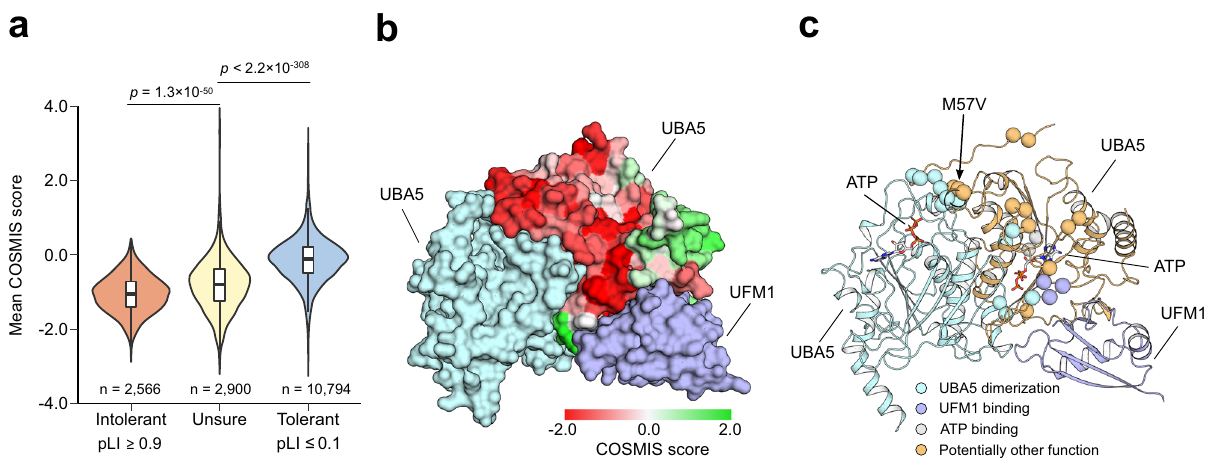
Fig. 4 The COSMIS score quanti fi es constraint at amino acid resolution and provides structural insights into variant pathogenicity. a COSMIS score distributions are signi fi cantly different between loss of function tolerant, unsure, and intolerant (as de fi ned by pLI) genes. The COSMIS scores of amino acid sites in intolerant genes differ from those in tolerant genes (median − 1.1 vs − 0.12). Statistic test: two-sided Mann – Whitney U test. In boxplot graphs center line indicates median, bounds of box indicate 25th and 75th percentiles, and whiskers indicate minimum and maximum. b COSMIS scores of UBA5 sites mapped to structure of one subunit of a dimerized UBA5 bound with the UFM1 target protein (PDB ID: 6H77). UBA5 is predicted to be LoF tolerant, but it exhibits substantial constraint on speci fi c spatial regions. Structures of all subunits of the complex are rendered in surface. c Locations of the top 10% most constrained sites in UBA5 ranked by COSMIS score. Sites are rendered in spheres and colored according to their likely functional roles. Location of variant M57V implicated in early-onset encephalopathy is indicated. Proteins are rendered in cartoons. We note that because the COSMIS score of a site is directly informed by the genetic variability of its contact set, it comes as natural to interpret the scores in the context of a 3D structure. pLI probability of loss-of-function intolerant, UBA5 ubiquitin-like modi fi er-activating enzyme 5, UFM1 ubiquitin-fold modi fi er 1, ATP adenosine triphosphate. Source data are provided as a Source Data fi